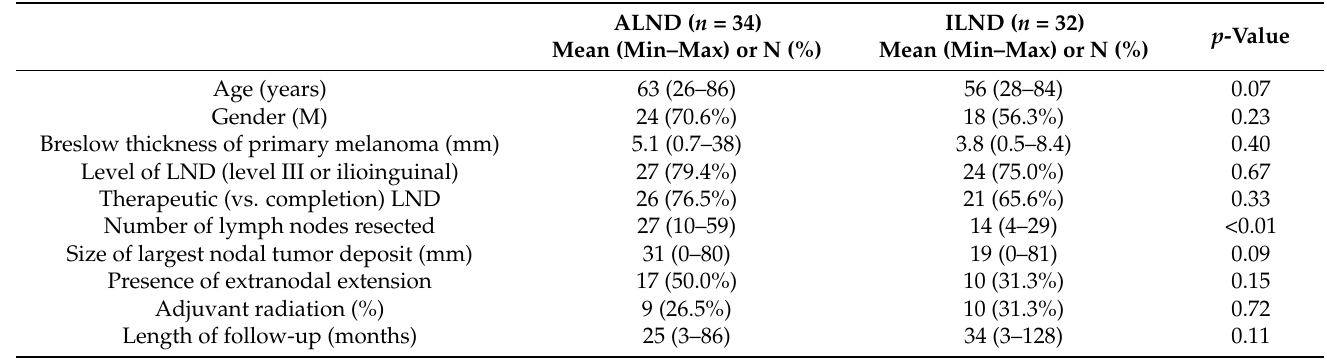
Table 1. Patient Demographics and Treatment